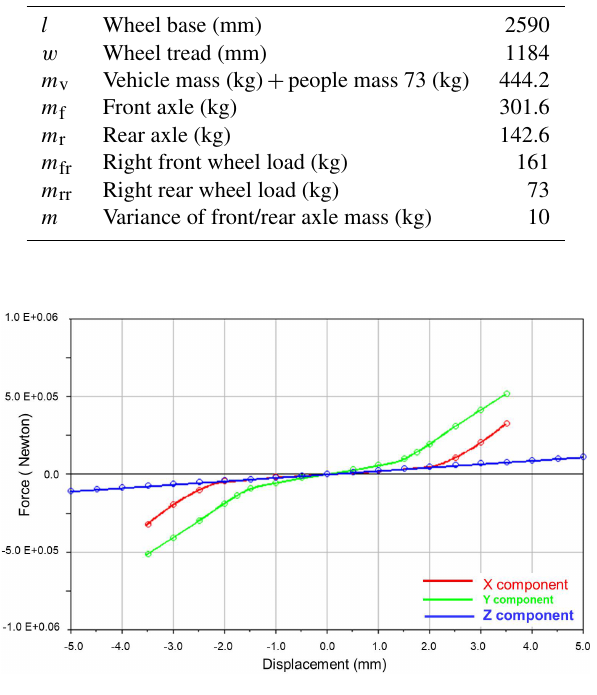
Figure 4. Bushing characteristic